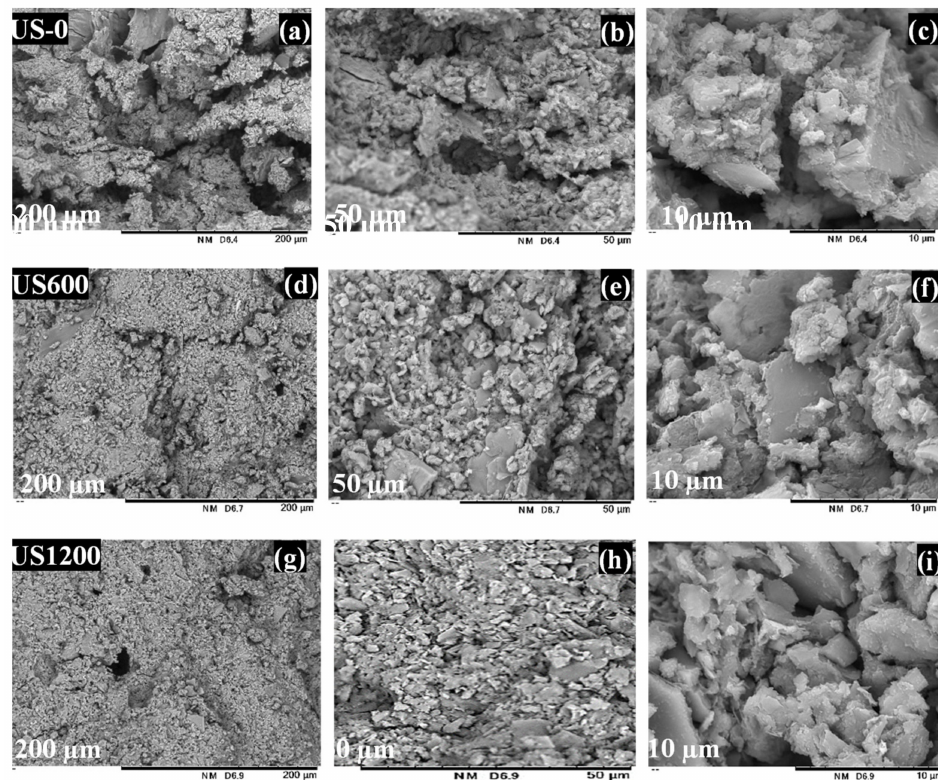
Figure 8. Microstructure of geopolymer sample after before and after ultrasonic treatment at di ff erent intensities. (0 W, 600 W, and 1200 W) of NH3, ( a – c ) US-0, ( d – f ) US-600, ( g – i ) US-1200.